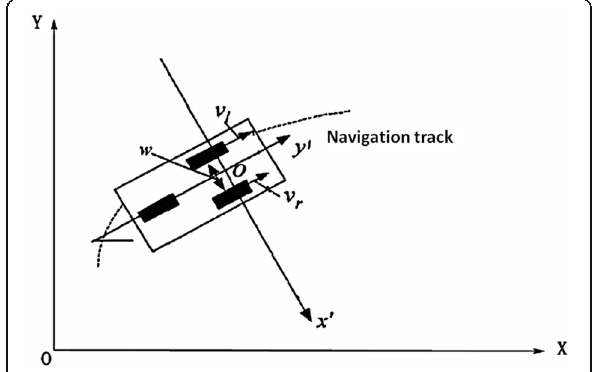
Fig. 1 Schematic diagram of automatic transport vehicle